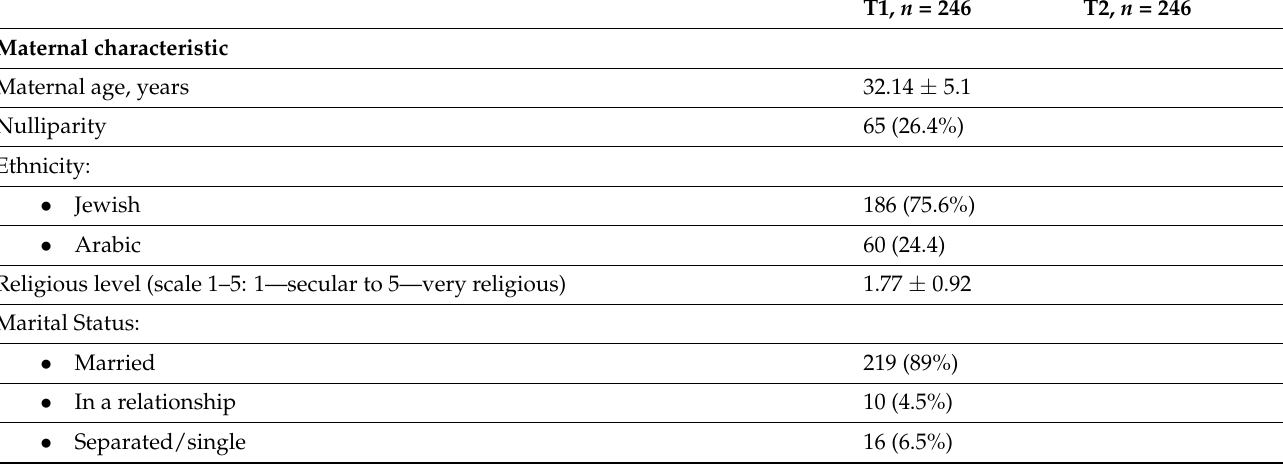
Table 1. Maternal characteristics and clinical measurements of the cohort group.